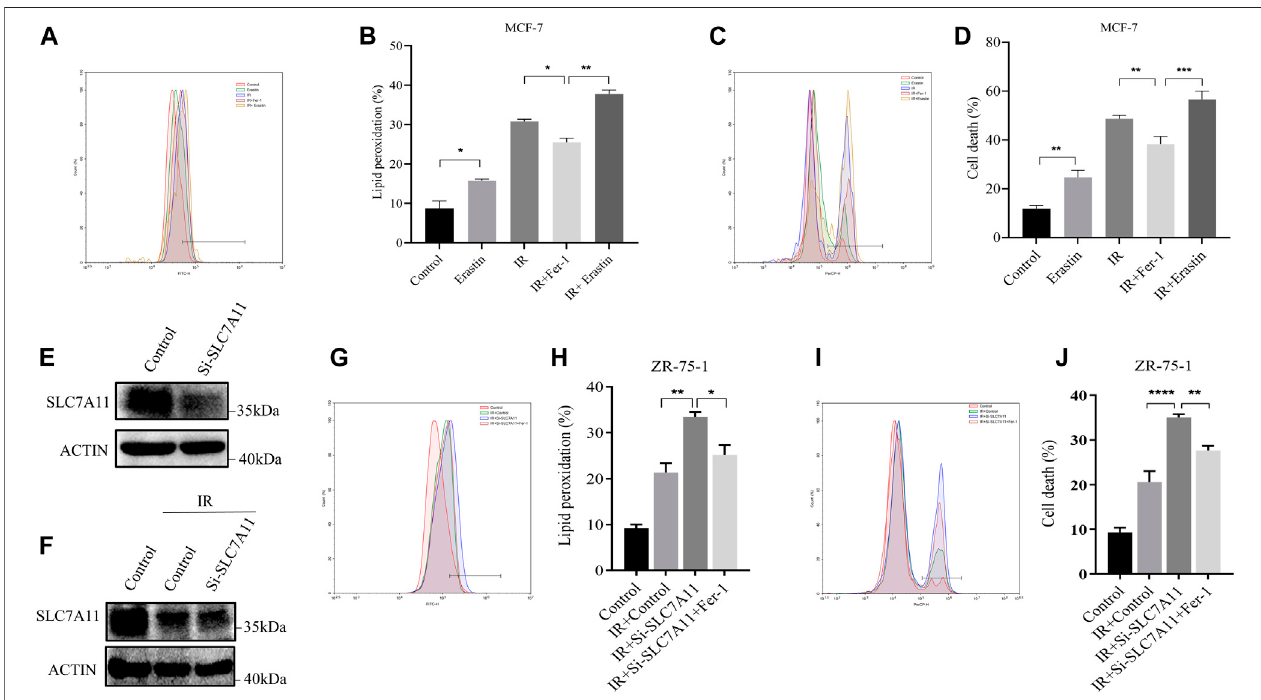
FIGURE2| IR-inducedferroptosisinER-positivebreastcelllines. (A – D) MCF-7cellswerepretreatedwithErastin(10 µM)orFer-1(10 µM)for1 handthenexposedto IR(8 Gy). (E – J) Westernblotand fl owcytometry analysisofferroptosisbySLC7A11downregulationinZR-75-1.Lipid peroxidation (A,B,G,H) and celldeath (C,D,I,J) were assessed by fl ow cytometry using C11-BODIPY and trypan blue, respectively. Shown is mean ± SD, n ≥ 3, * p < 0.05; ** p < 0.01; *** p < 0.001; **** p < 0.0001.